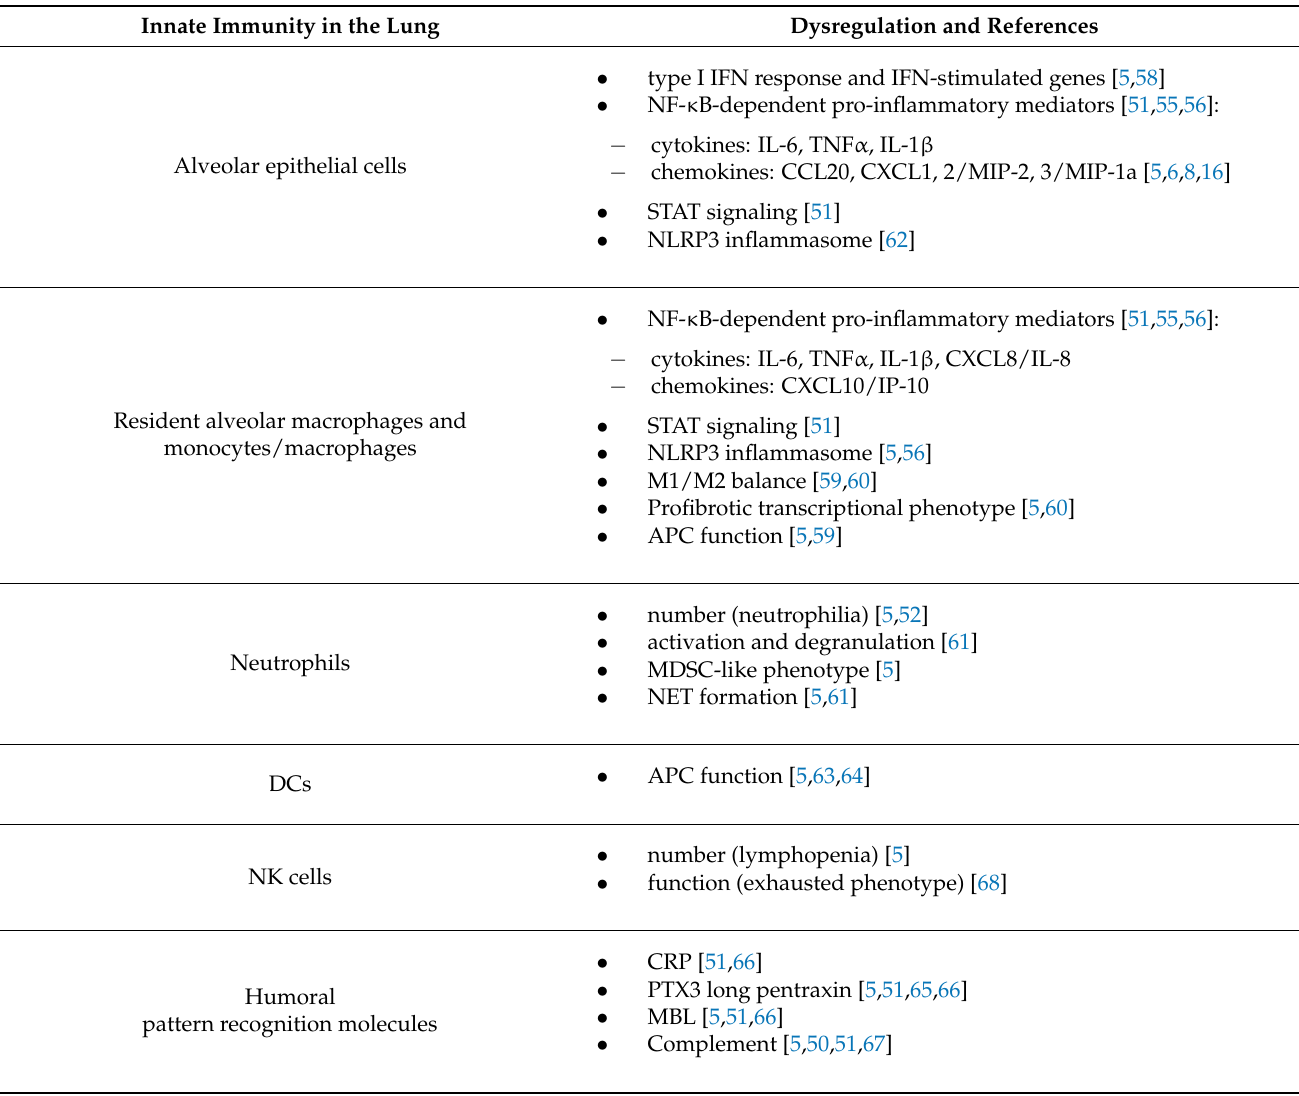
Table 3. Immunological biomarkers associated with COVID-19 related